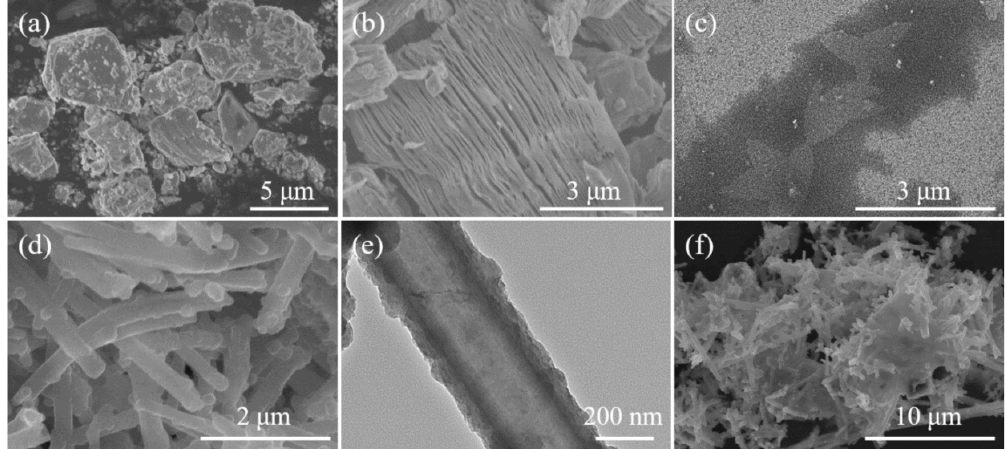
Figure 2. The synthesis of the MXene/PPy nanocomposite. A FESEM image of ( a ) Ti 3 AlC 2 powders, ( b ) Ti 3 C 2 T x powders, ( c ) Ti 3 C 2 T x nanosheets, and ( d ) PPy nanowires; ( e ) a TEM image of the PPy nanowire; ( f ) a FESEM image of the MXene/PPy nanocomposite.